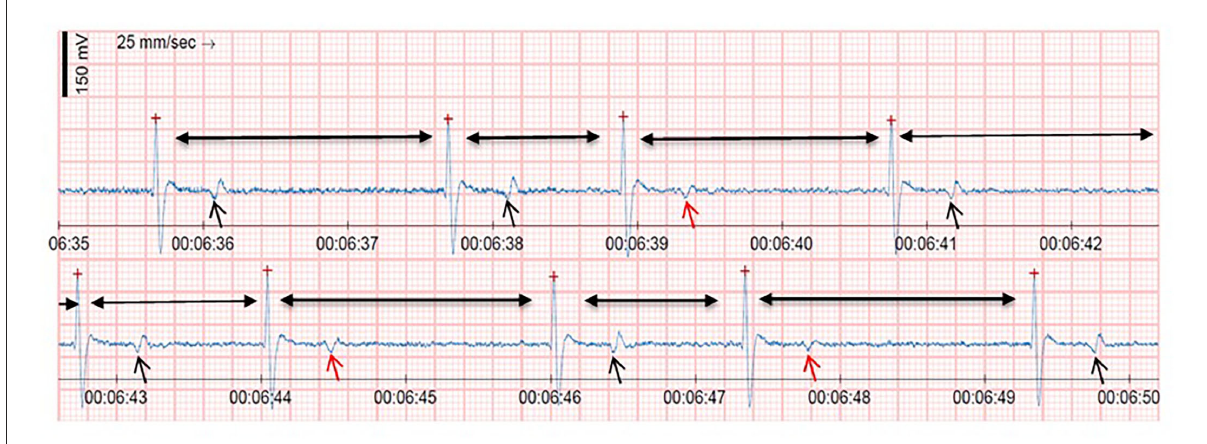
FIGURE3 Shows continuous ECG trace from Equimetre TM for clinical male camel suffering paraphimosis referred to King Faisal Veterinary Teaching Hospital. ECG trace revealed heart rate of 36 bpm associated with three junctional premature beats (JPB). Moreover, ECG trace showed a different T-waves polarity in which black arrows showed a normal complex followed by biphasic T-Waves and red arrow showed JPB followed by T( − ) waves.